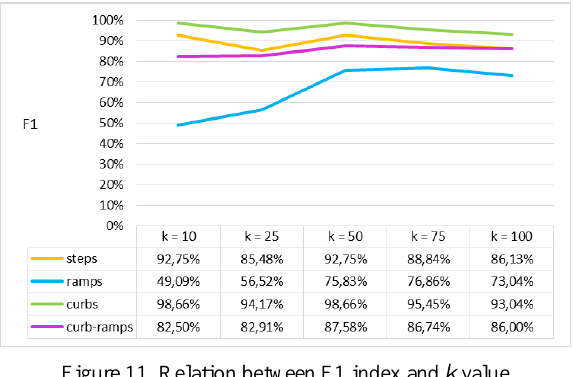
Figure 11. Relation between F1 index and k value